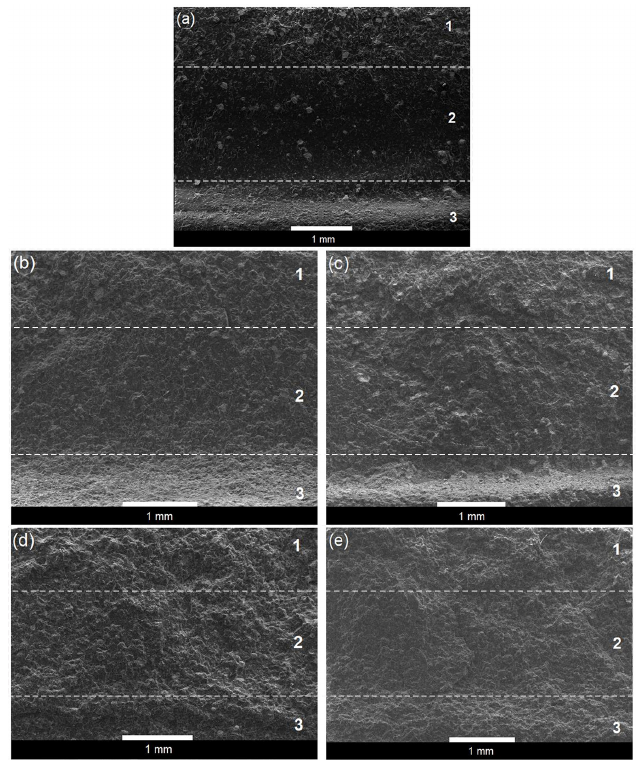
Figure 7. Scanning Electron Microscopy (SEM) micrographs of the bending fracture surfaces of the ( a ) reference bone cement and the bone cements prepared with 15 wt % of structured nanoparticles ( b ) 20 / 80, ( c ) 30 / 70, ( d ) 40 / 60, and ( e ) 50 / 50. Number 1 indicate the compression band, number 2 the transition band, and number 3 the tensile band.